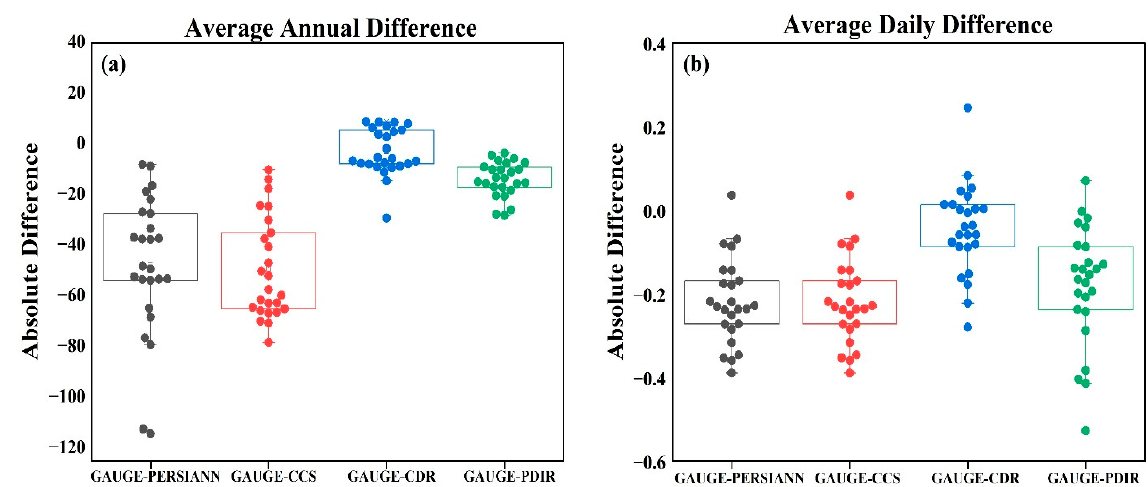
Figure 4. The absolute difference between average annual ( a ) and daily ( b ) values between the gauge and satellite products from 2011 to 2020.